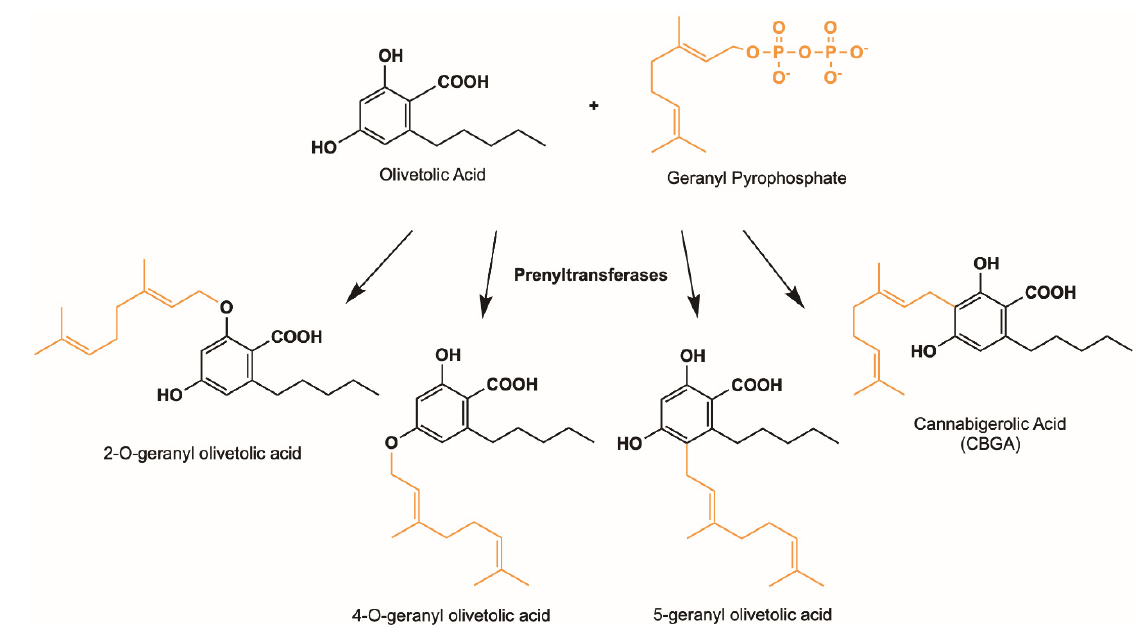
Figure 8. Possible cannabinoid products using OLA (black) and GPP (orange) as substrates.